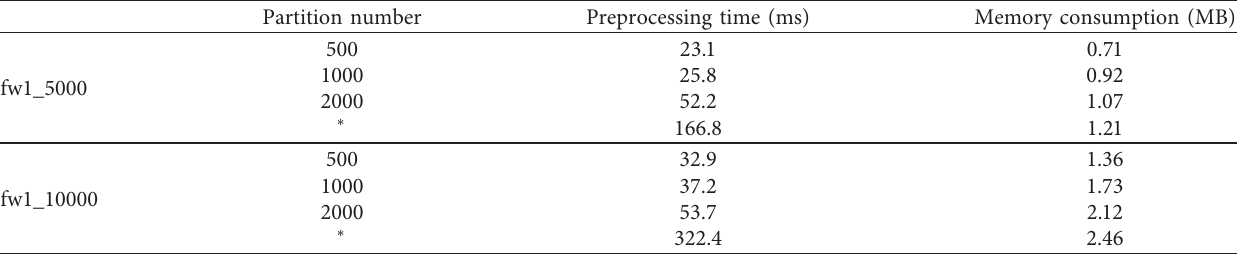
Table 4: The preprocessing time and memory consumption for different partition numbers in subsets ( ∗ means no partitioning is done).